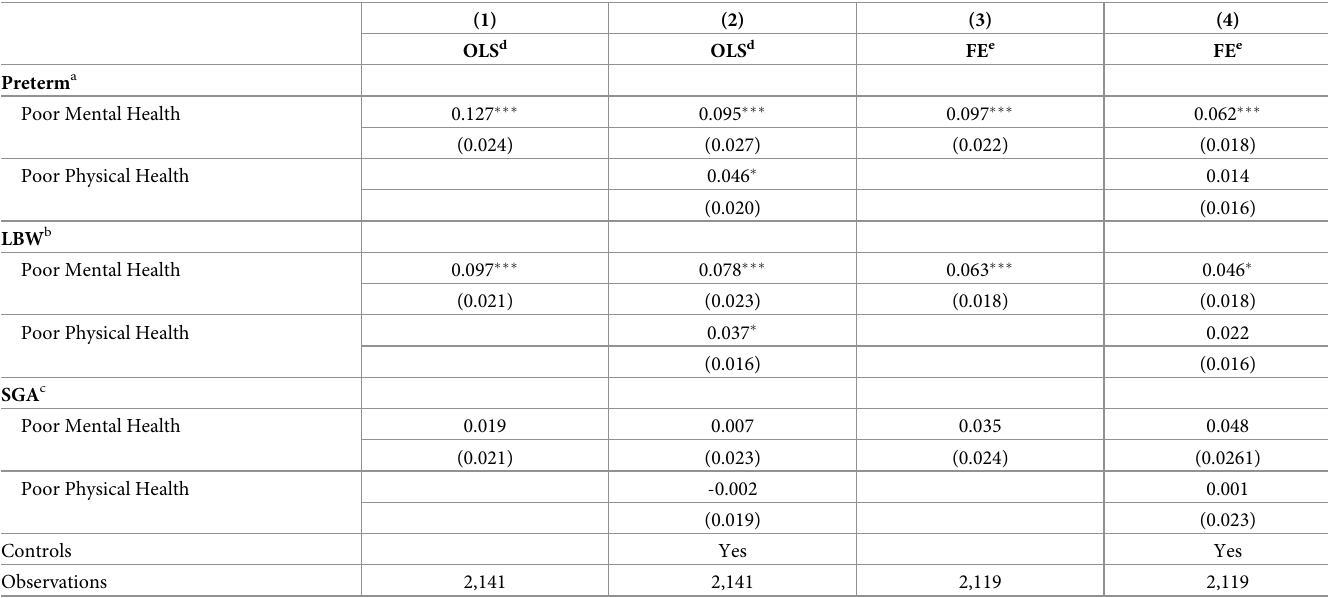
Table 1. OLS and FE